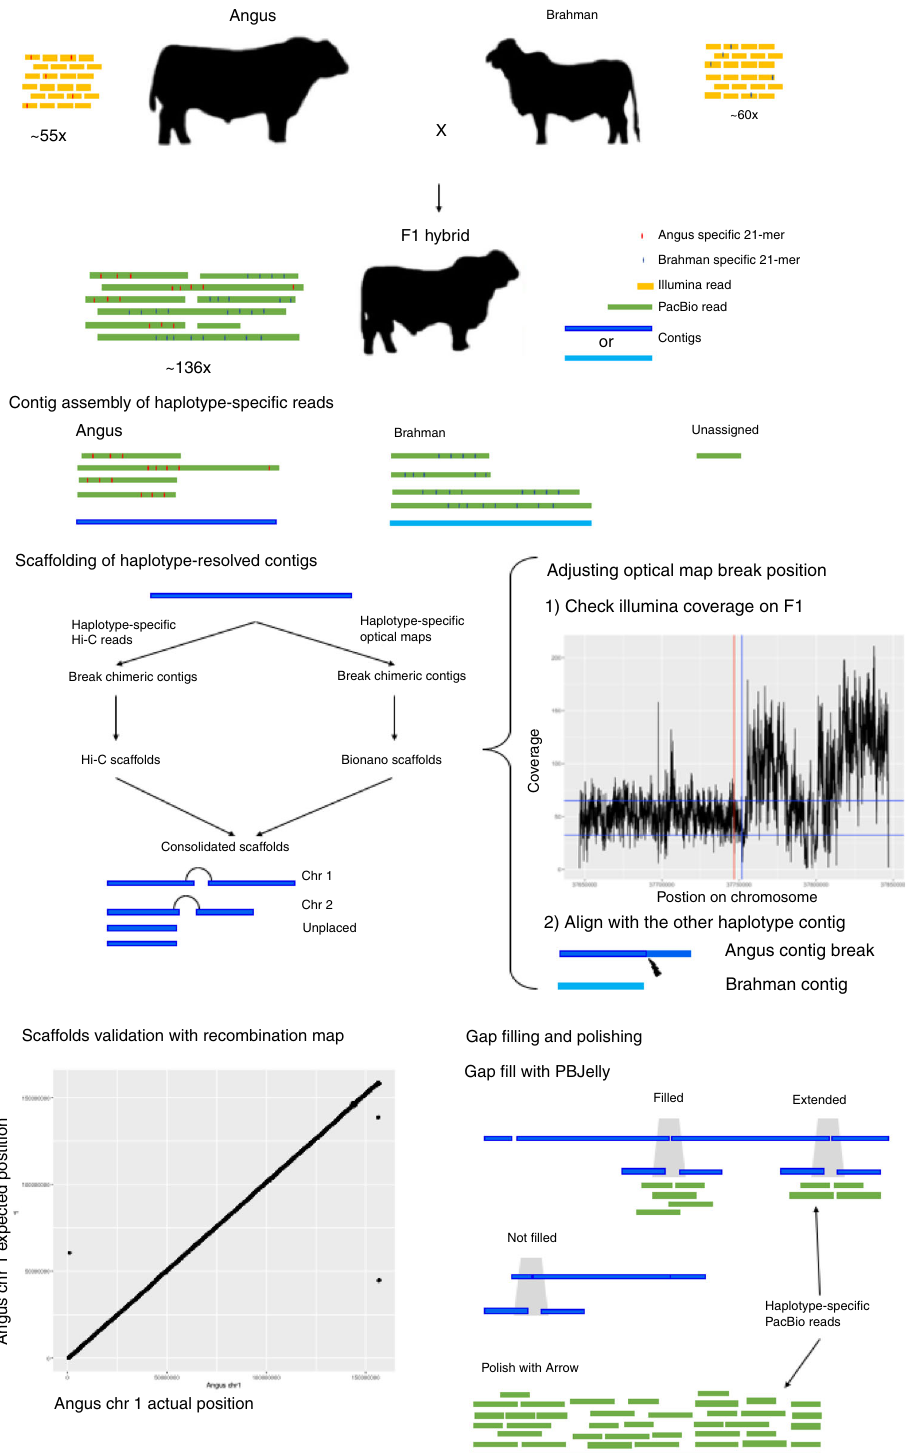
Fig. 1 An overview of the assembly methods. Long PacBio reads were binned to the respective haplotypes using parental-speci fi c k -mers and unassigned reads were discarded. TrioCanu was used to assemble sequences from each haplotype into haplotigs. Each set of haplotigs was scaffolded separately with both Hi-C and optical map data (illustrated only for the Angus). Optical map breakpoints were accepted but are imprecise. Therefore, breakpoint positions were improved by observing if there are local drops in short-read coverage and/or where there is a break sequence alignment with the alternative haplotig. Hi-C and optical map-based scaffolds were checked for consistency and combined as a single set of scaffolds. Cattle recombination maps were used to validate the assembly. Each point on the scatter plot is the actual recombination marker coordinate on the latest reference genome and the expected position based on previous reference genome, UMD3.1. Finally, haplotype-speci fi c long reads were used to fi ll gaps and polish the